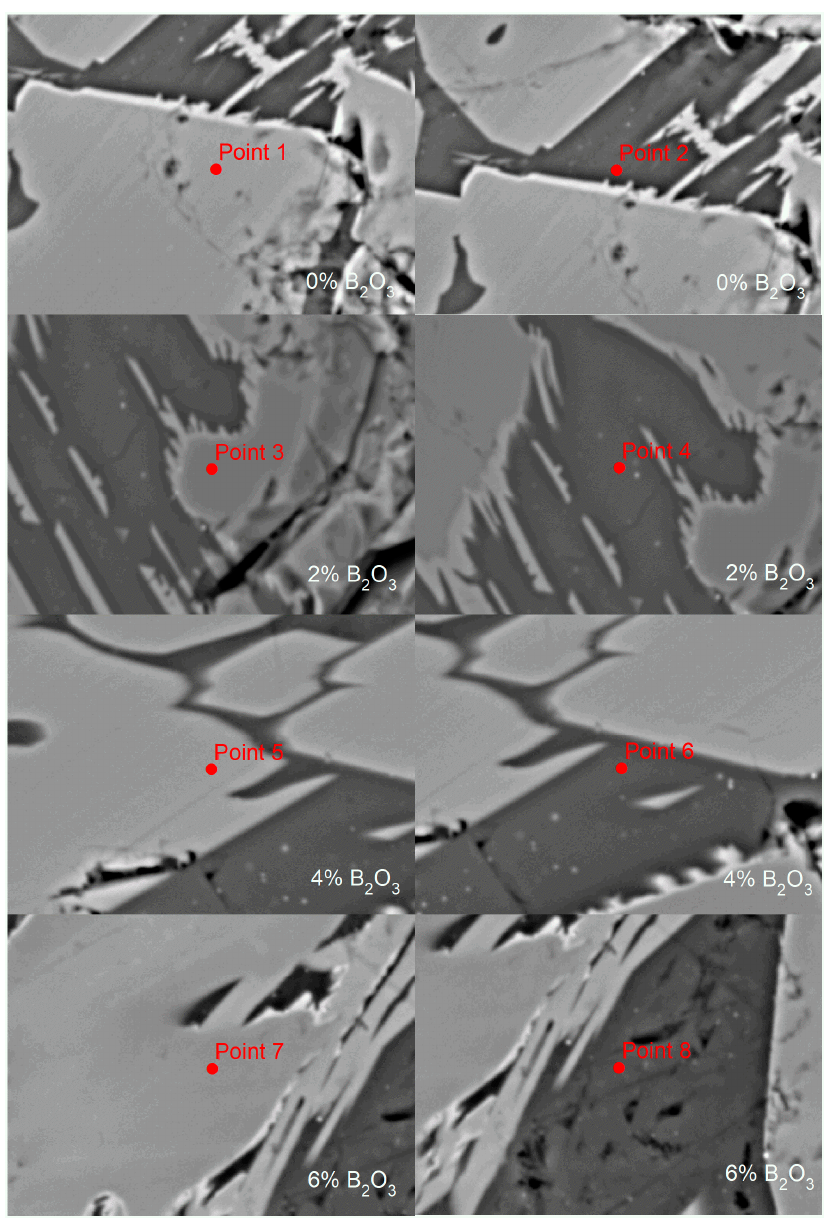
Figure 2. The backscattered electron image of the cross-section of block sample of modified titanium slag with different additive (B 2 O 3 ) amounts.